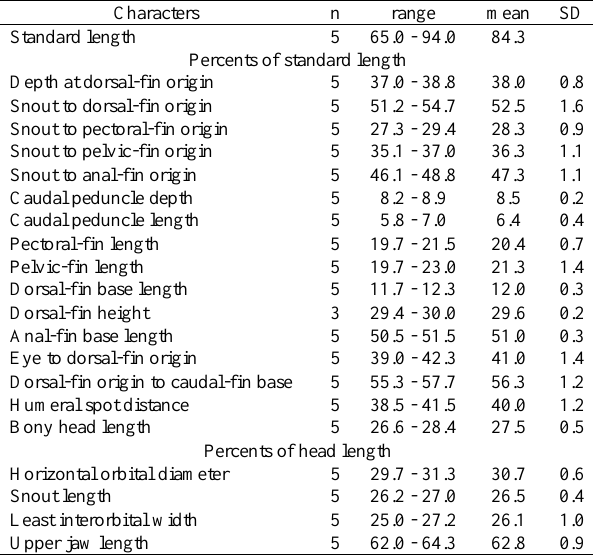
Table 8 . Morphometrics of Charax macrolepis . Specimens are from MZUSP 33423,